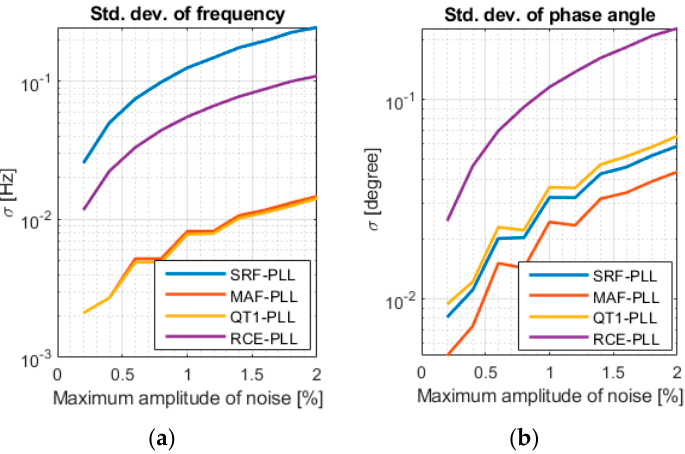
Figure 18. Effect of three-phase signal noise on parameters of interest. ( c ) Standard deviation of Figure 18. E ff ect of three-phase signal noise on parameters of interest. ( a ) Standard deviation of frequency; ( d ) standard deviation of phase angle. frequency; ( b ) standard deviation of phase angle.